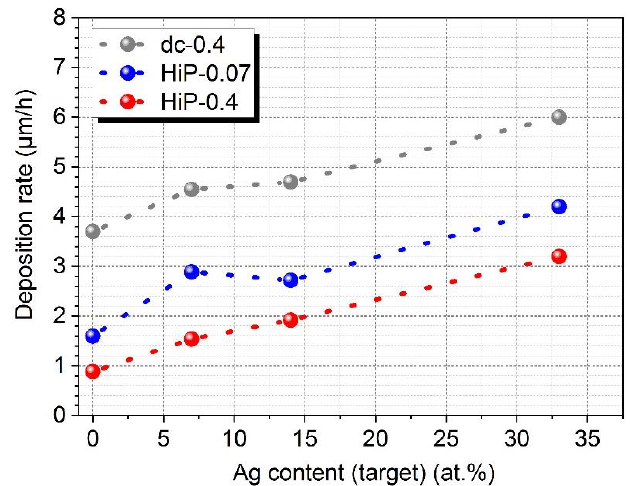
Figure 4. Deposition rate vs. Ag content (target) of MoN and MoN-Ag coatings.